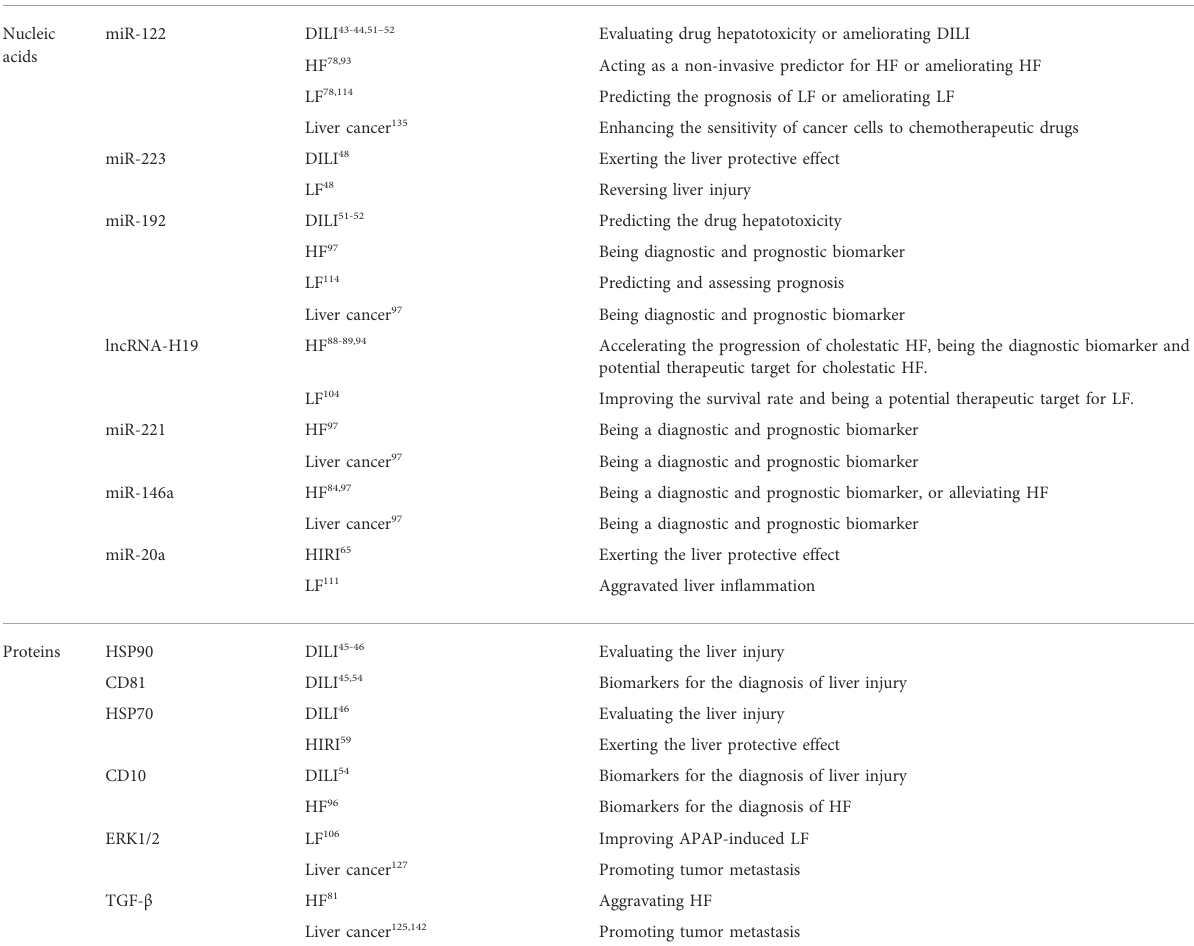
TABLE 6 Overview of the roles of nucleic acids and proteins carried by exosomes in different liver